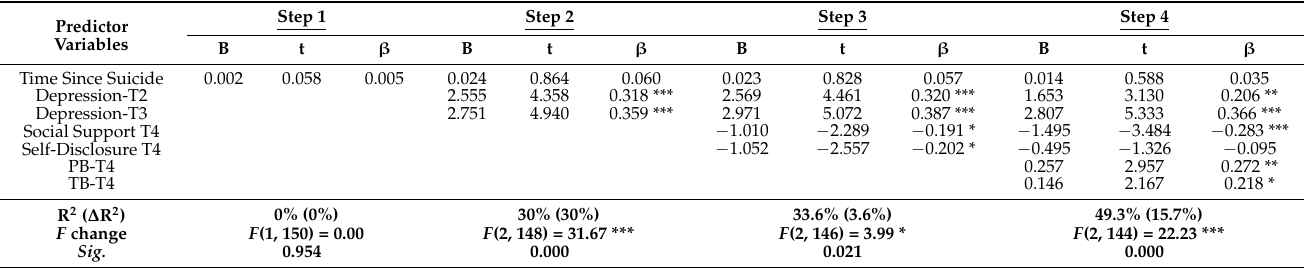
Table 2. Summary of Hierarchical Regression Coefficients of Depression among SLSs by Previous Depression and Interpersonal Variables. ( N =